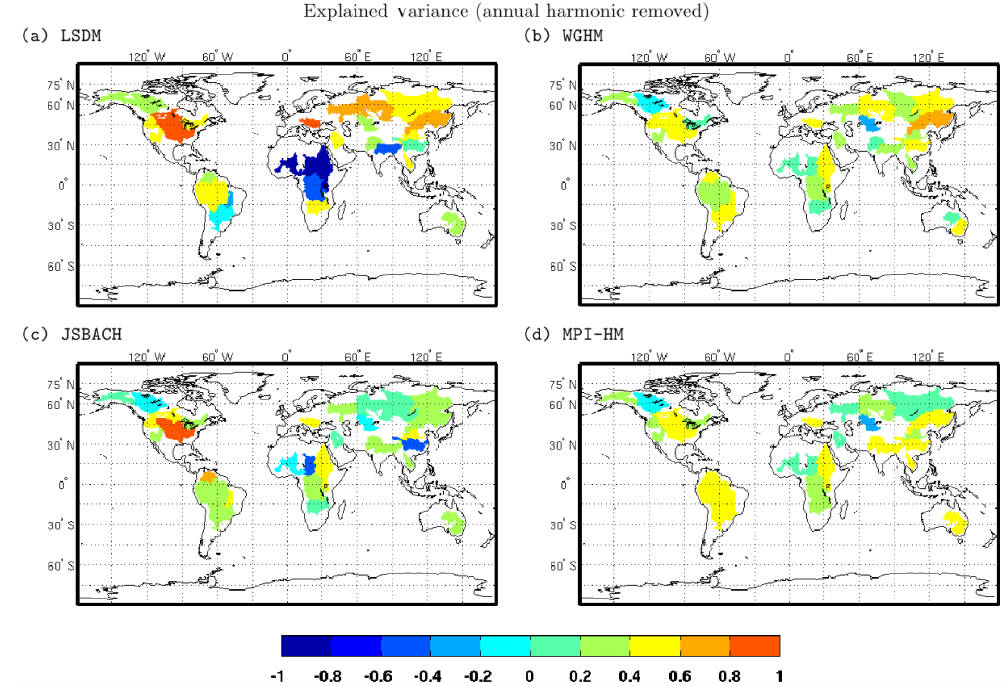
Figure 5. Variance of GRACE-based TWS observations that is explained by TWS as simulated in four hydrological model realizations. For both observations and model results, the annual harmonic signal has been